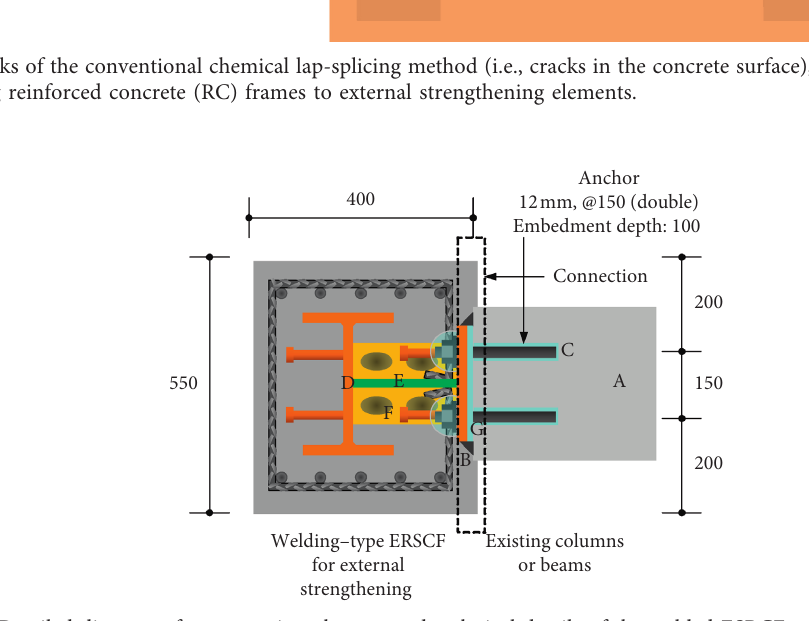
Figure 2: Detailed diagram of a connection element and technical details of the welded ESRCF strengthening system. Table 1: Construction procedure for the welded ESRCF strengthening